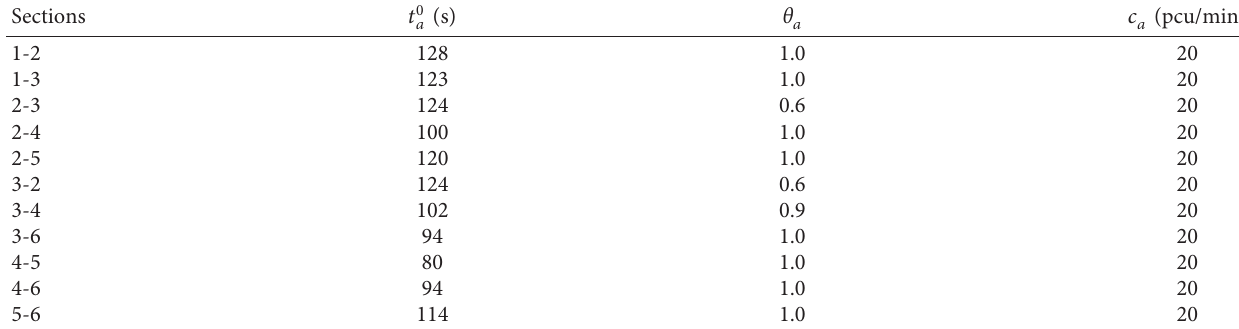
Table 1: Basic tables.